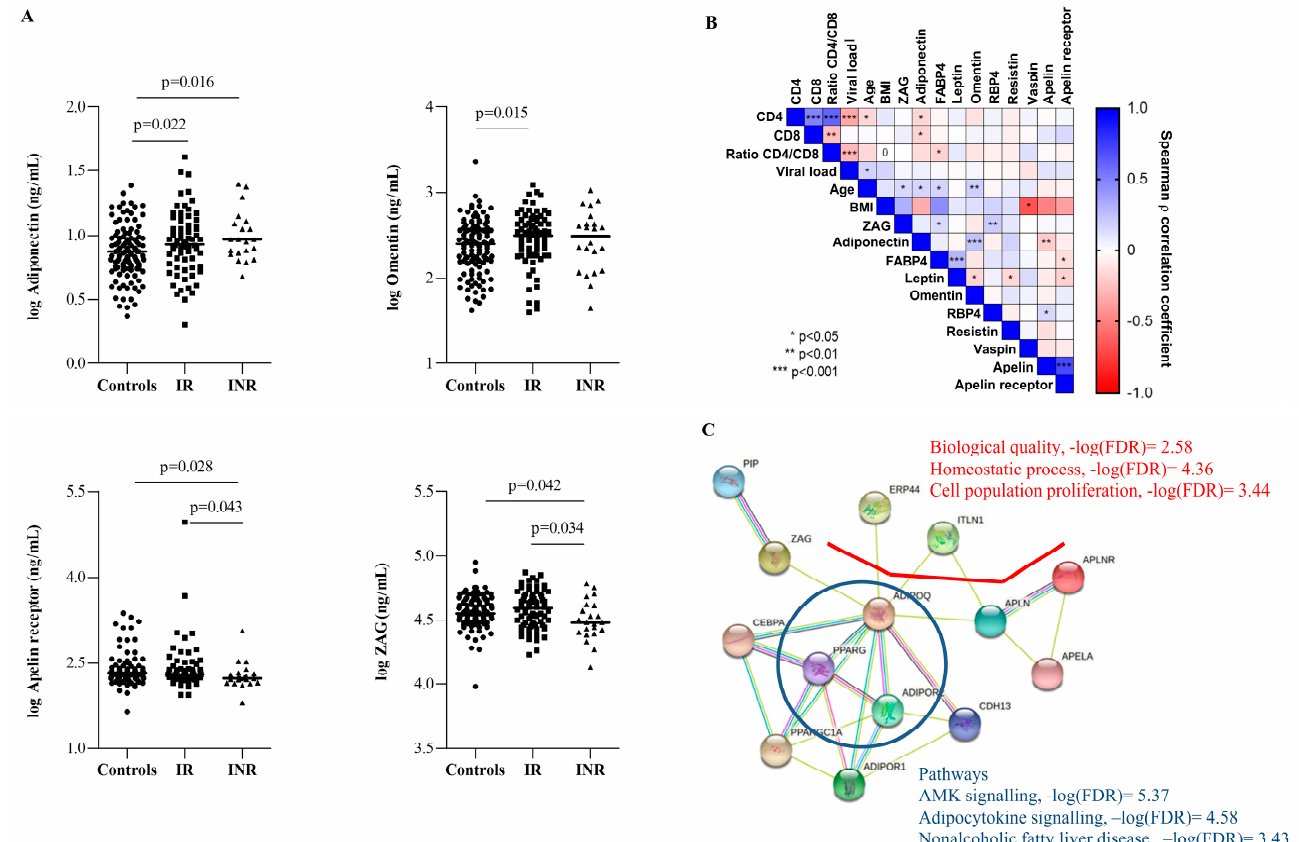
Figure 2. Circulating adipokine concentrations before initiating ART. ( A ) Baseline concentrations of adiponectin, omentin, APLNR, and ZAG in controls ( n = 120), IRs ( n = 77), and INRs ( n = 22). p -value indicates significant differences among indicated groups by nonparametric Mann–Whitney